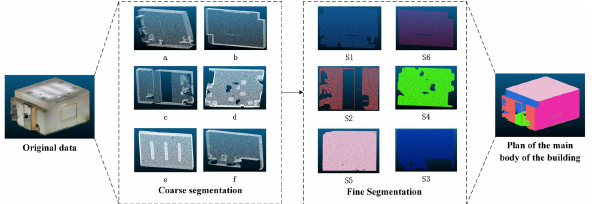
Figure 3 . Multi-level planar extraction process.